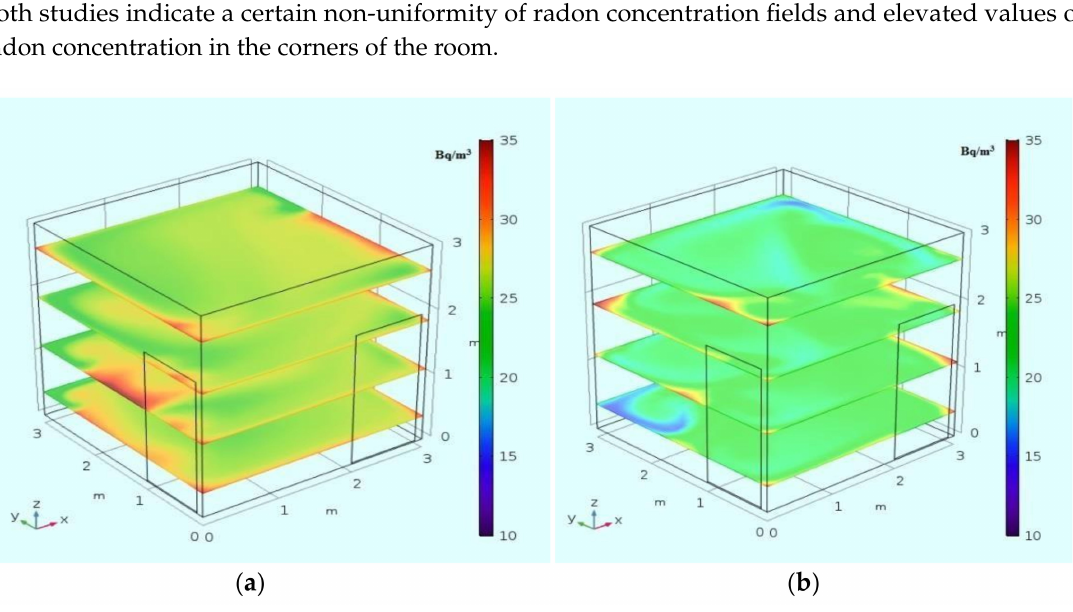
Figure 2. Radon concentration in the room for the case of exhalation of radon from the walls [2]. ( a ) laminar flow; ( b ) k- ε turbulence